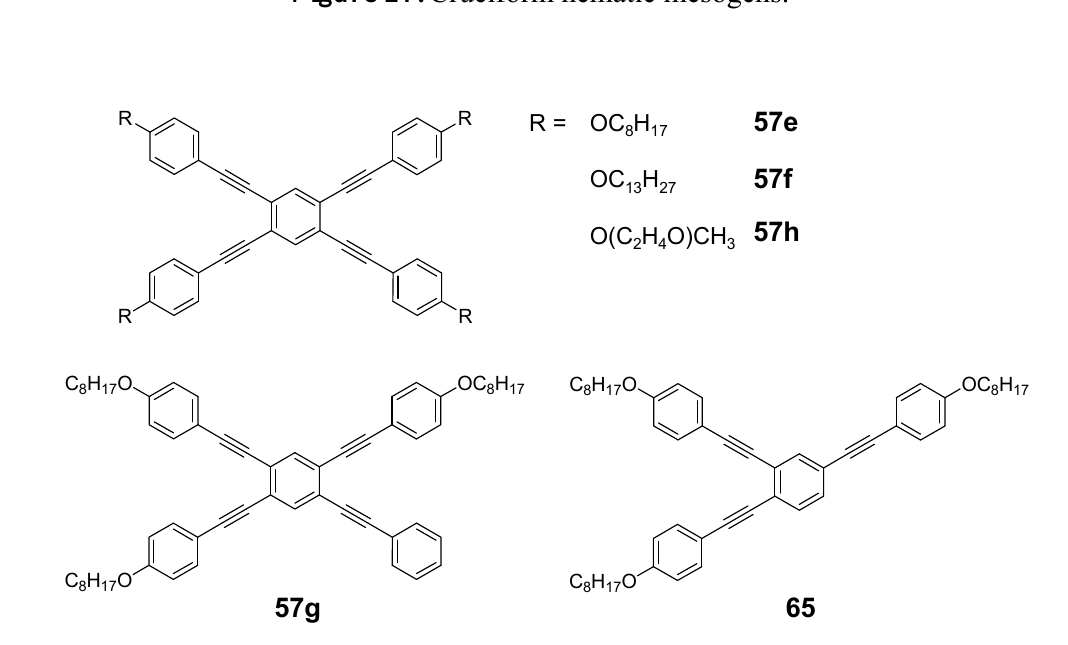
Figure 21. Cruciform nematic